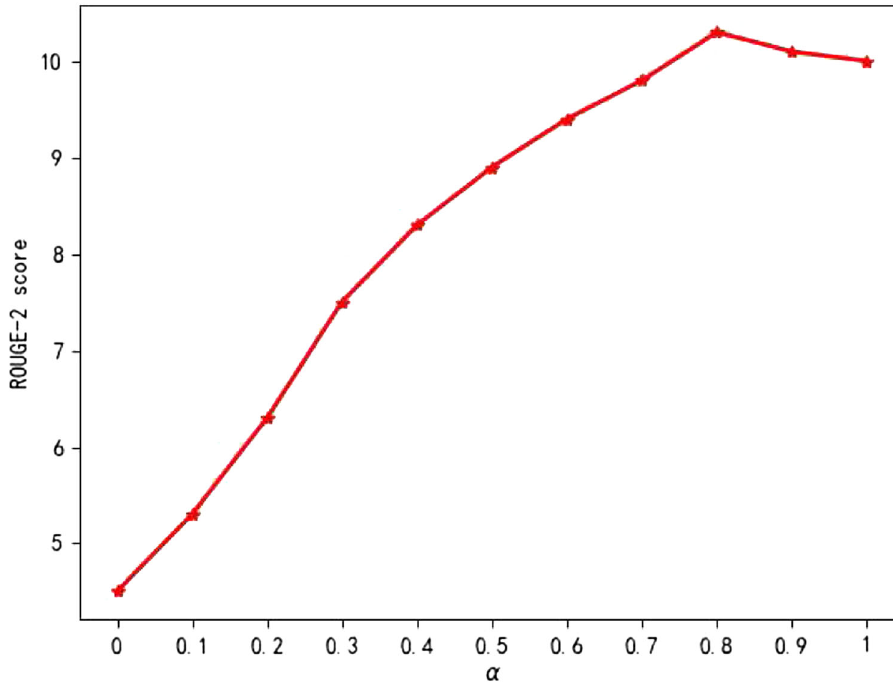
Fig. 2 ROUGE-2 scores vs. α on the test set